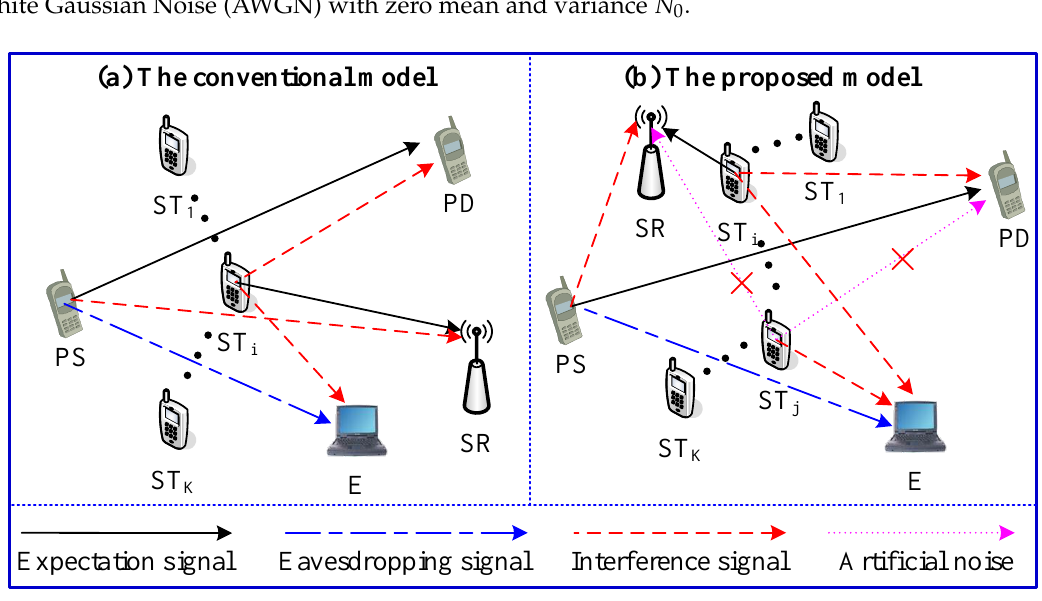
Figure 1. The system